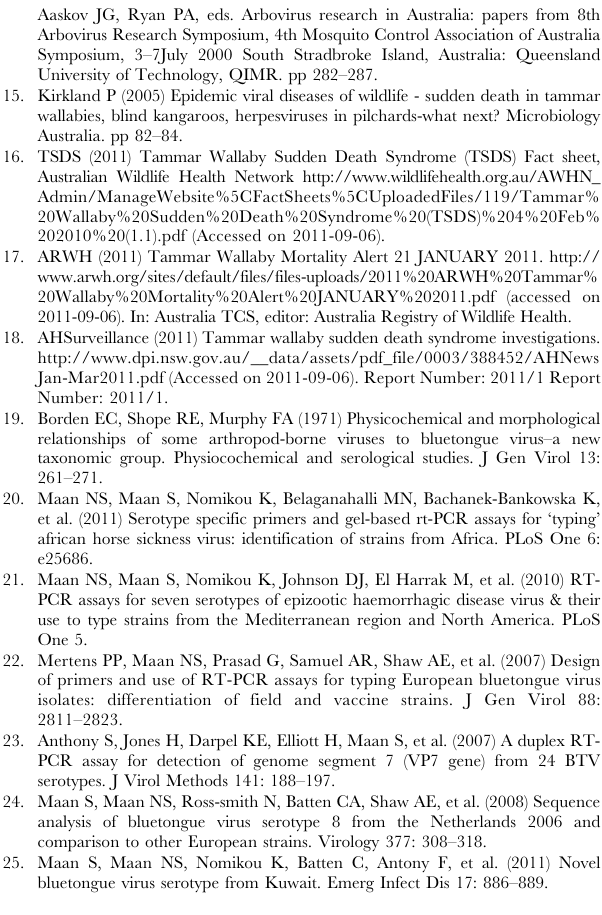
Figure S1 Hydrophobicity profiles of orbivirus NS4 proteins. Superimposed hydrophobicity profiles based on multiple alignment of orbivirus NS4 amino acid sequences, generated using Clustal X2. The residue numbers are relative to